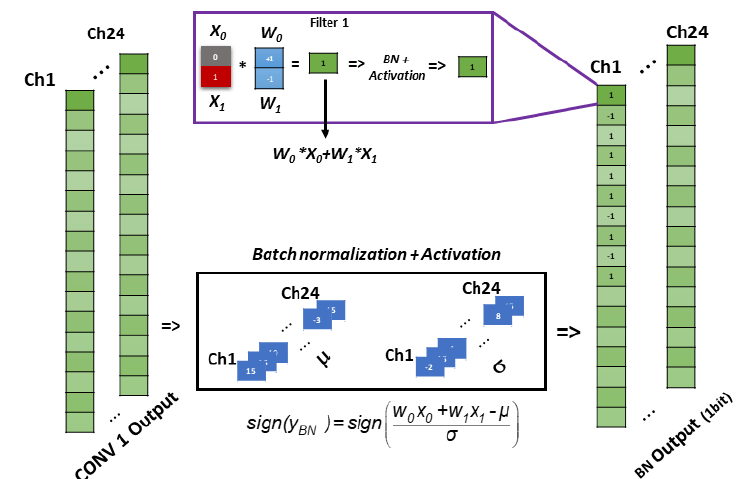
Figure 3. Operations of the BN and Activation functions.